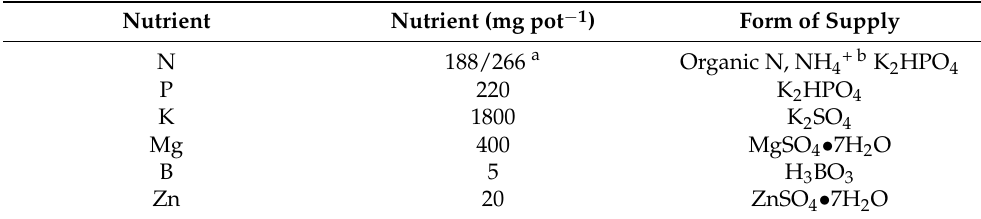
Table 5. Form of supply and amounts of macro- and micronutrients to each pot supplied at the start of the experiment, after the second and after the fourth grass harvest. Nitrogen was only supplied once via the test materials at the start of the experiment.